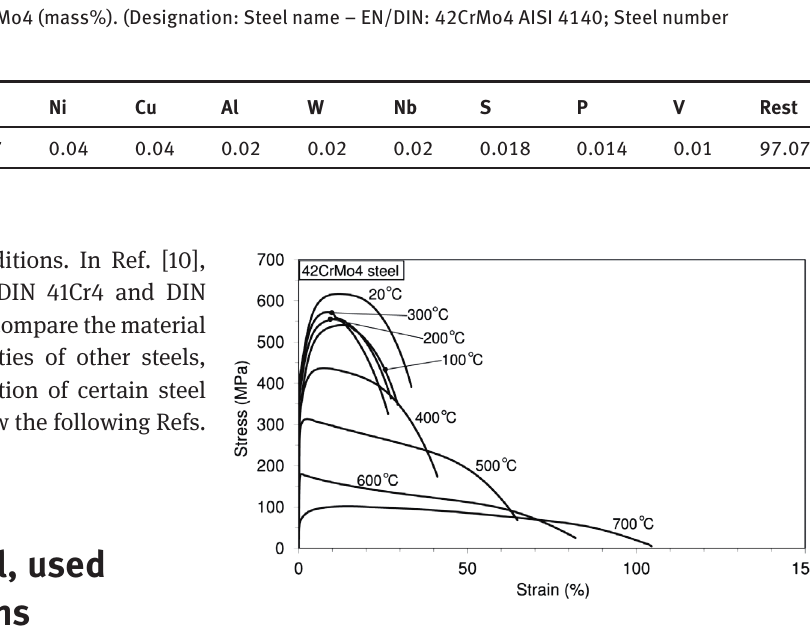
Fig. 1: Engineering stress-strain diagrams of 42CrMo4